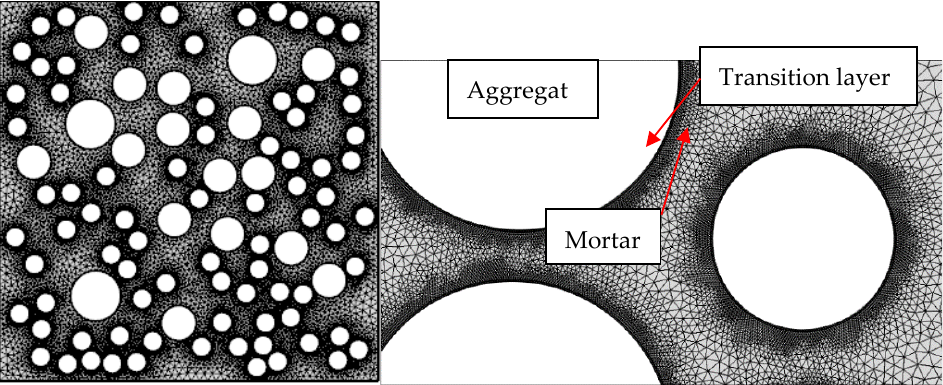
Figure 12. Random aggregate finite element model.